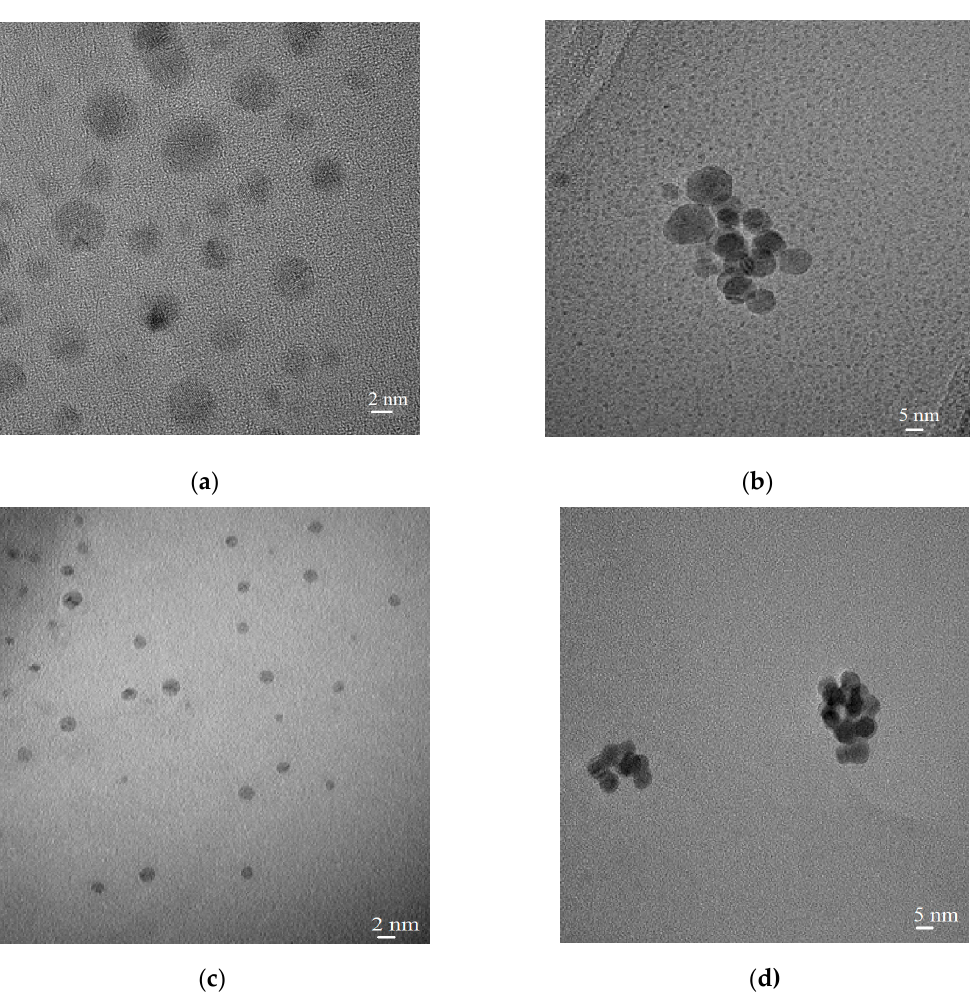
Figure 2. UV-VIS spectra of nanoparticles: ( a ) Ag with a particle size of 5 nm, ( b ) Ag with a particle size of 10 nm, ( c ) Au with a particle size of 5 nm, and ( d ) Au with a particle size of 10 nm.